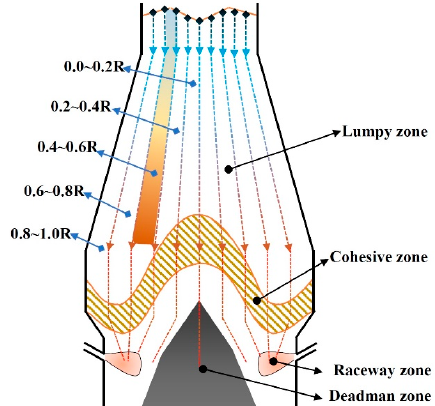
Figure 2. Burden path lines in the blast furnace (BF). Metals 2019 , 9 , 1003